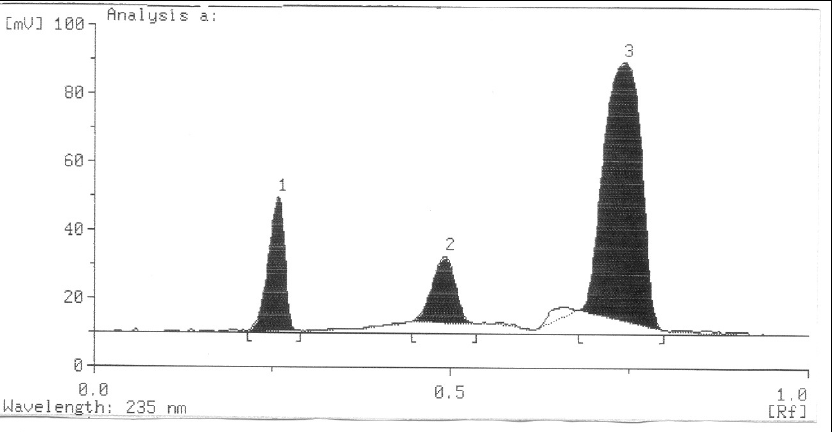
Figure 3. Typical chromatogram Peak, (1) Rosiglitazone maleate (internal standard), (2) Tizanidine and (3)